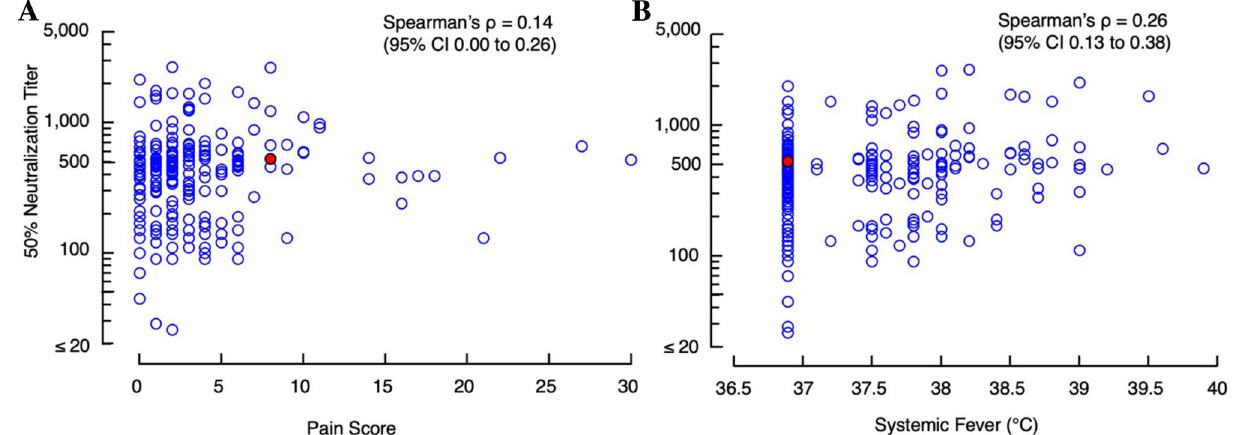
Figure 2. Correlations of neutralizing titers with injection-site pain scores and systemic fever grades. ( A ) No correlation was seen between NT 50 values and injection-site pain (Spearman’s ρ = 0.14; 95% CI 0.00–0.26, p = 0.043). The injection-site pain following the 2nd BNT162b2 dose was scored by using the short-form McGill Pain Questionnaire 23 . ( B ) Correlation was negligible between NT 50 values and systemic fever grades (Spearman’s ρ = 0.26; 95% CI 0.13–0.38, p < 0.001). A solid-red circle indicates a person with previous SARS-CoV-2 infection documented.